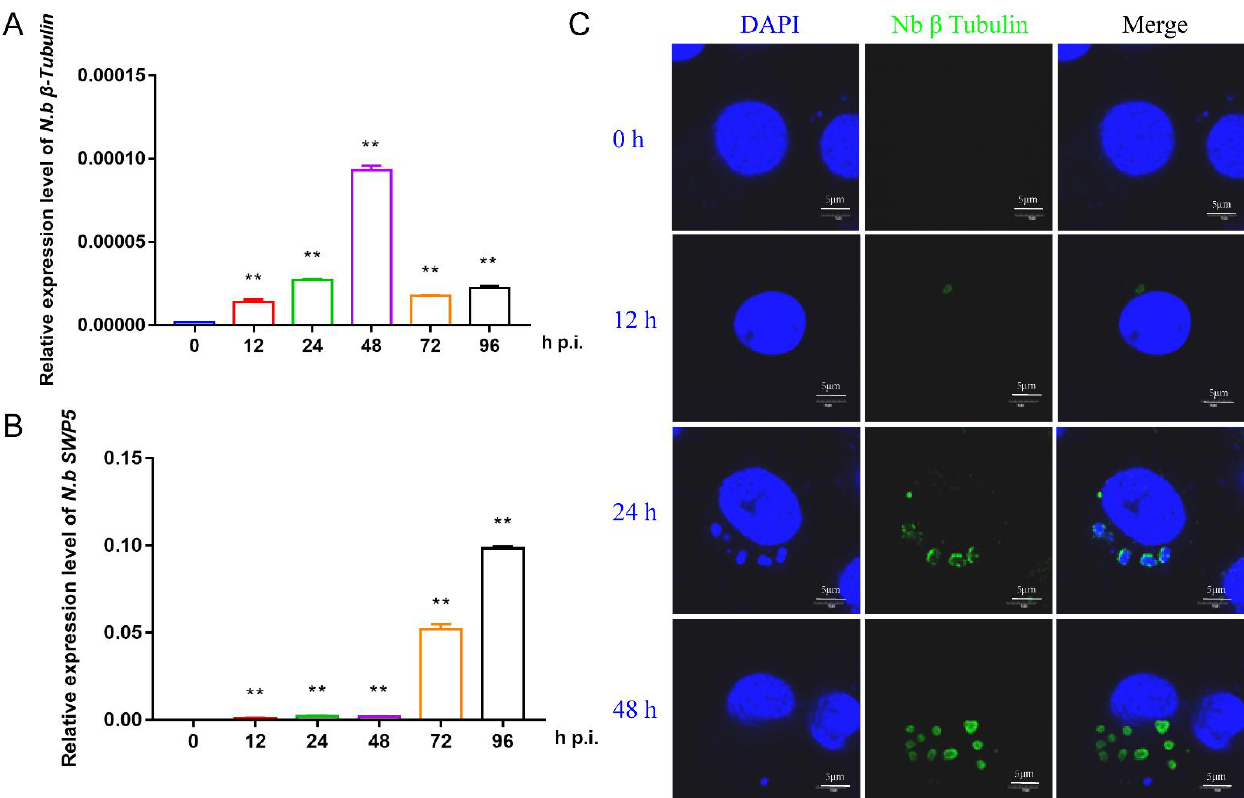
Figure 1. Characterization of the proliferation of N. bombycis in BmE cells ( A ) The expression level of the N. bombycis β -tubulin gene at different time points in BmE cells. ( B ) The expression level of N. bombycis swp5 at different time points in BmE cells. ( C ) Immunofluorescence analysis of schizont location in BmE cells at different time points. DAPI staining represents cell nuclei, and green fluorescence represents the β -tubulin protein of N. bombycis . All data represent the means of three replicates ± SD, **, p <